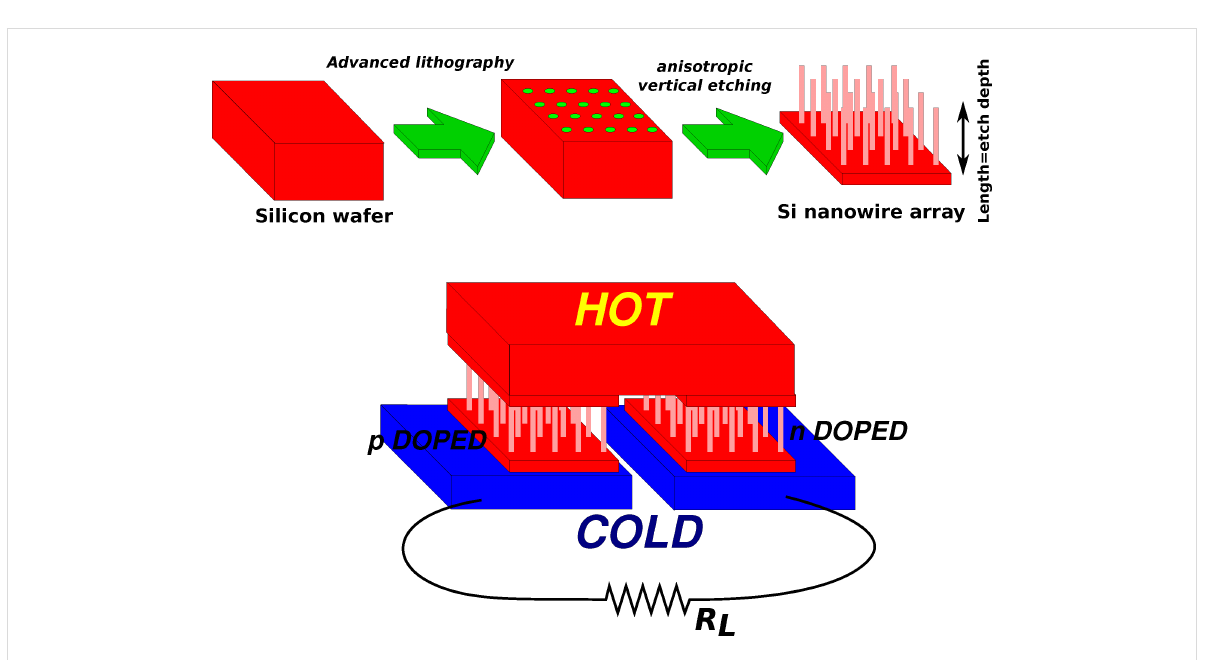
Figure 12: Sketch of the fabrication of vertical nanowire arrays. A sketch of a thermoelectric generator, based on vertical SiNWs, is also shown. Stan- dard silicon doping processes can be used for the fabrication of both n- and p-doped nanowires.